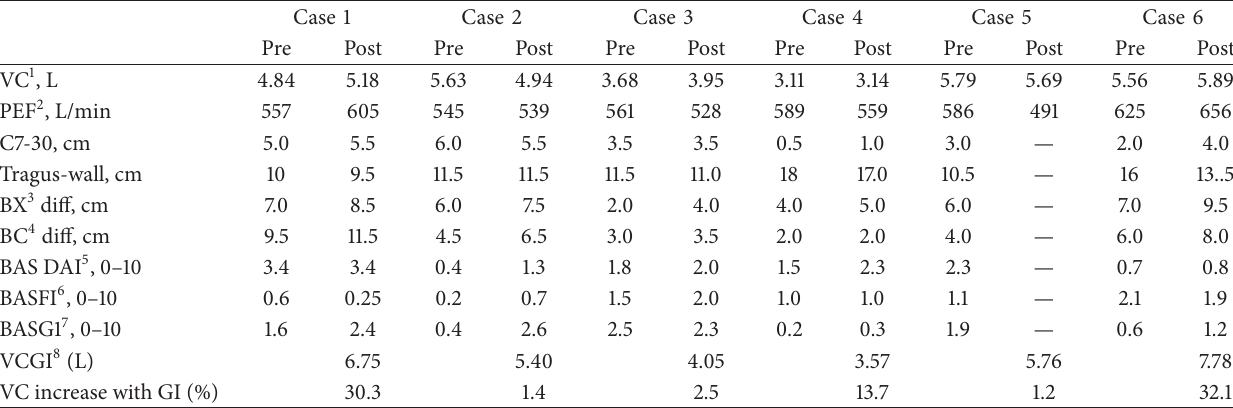
Table 2: Individual results from baseline (pre) and follow-up after 12 weeks (post) of Glossopharyngeal Insufflation for the six patients fulfilling the study